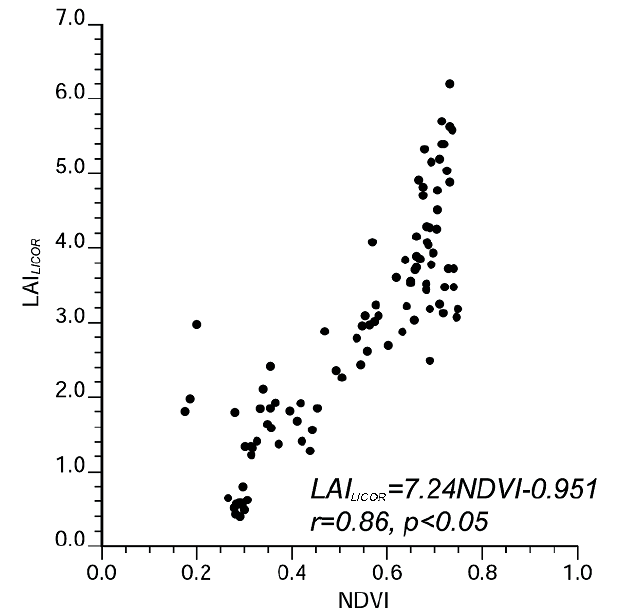
Figure 6. A linear relationship between the primary (LAI) and secondary (NDVI) variables is found with r = 0.86 at a significance level of